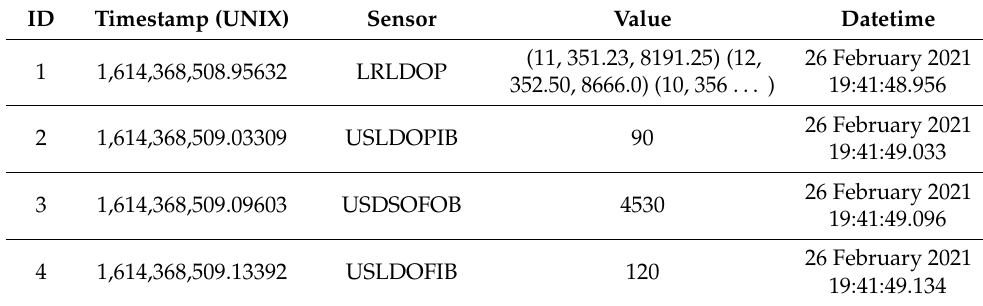
Table 4. Stored data in SQL